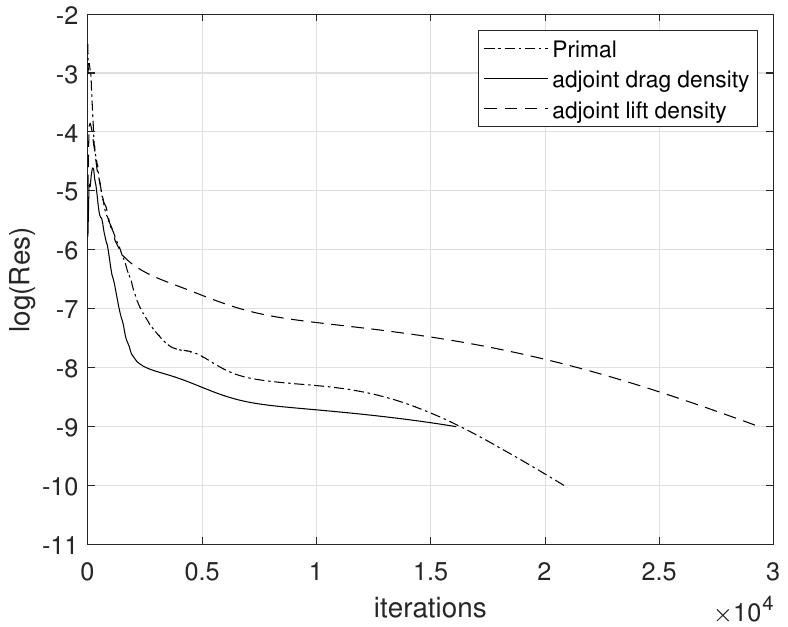
Figure 6. Convergence of the primal and adjoint CFD for the baseline rectangular wing geometry.